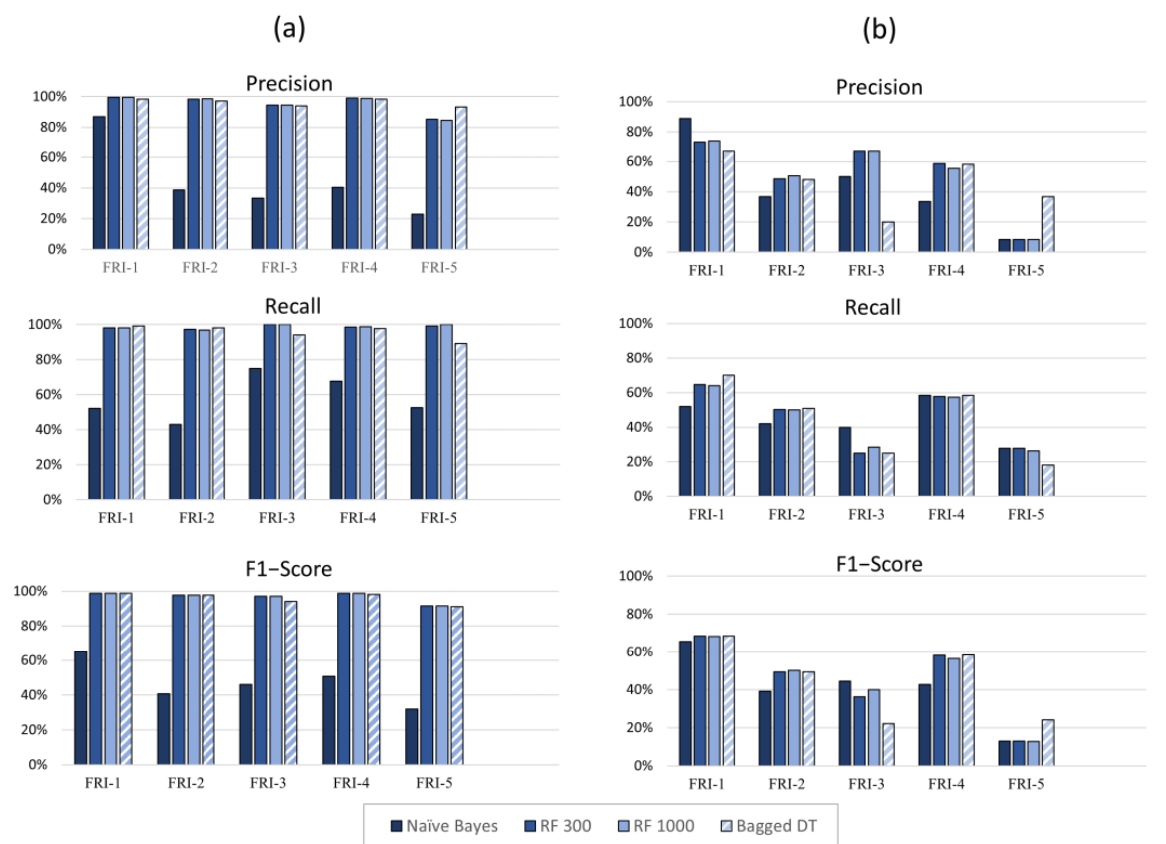
Figure 5. Prediction performance indices for the four utilized models where: ( a ) is the training subset performance, and ( b ) is the testing subset performance.